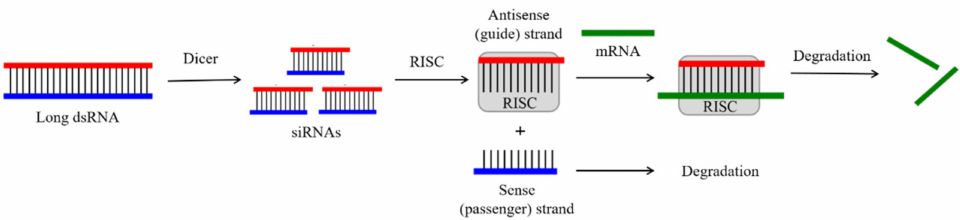
Figure 3. The mechanism of RNA interference (RNAi) mediated by small interfering RNAs